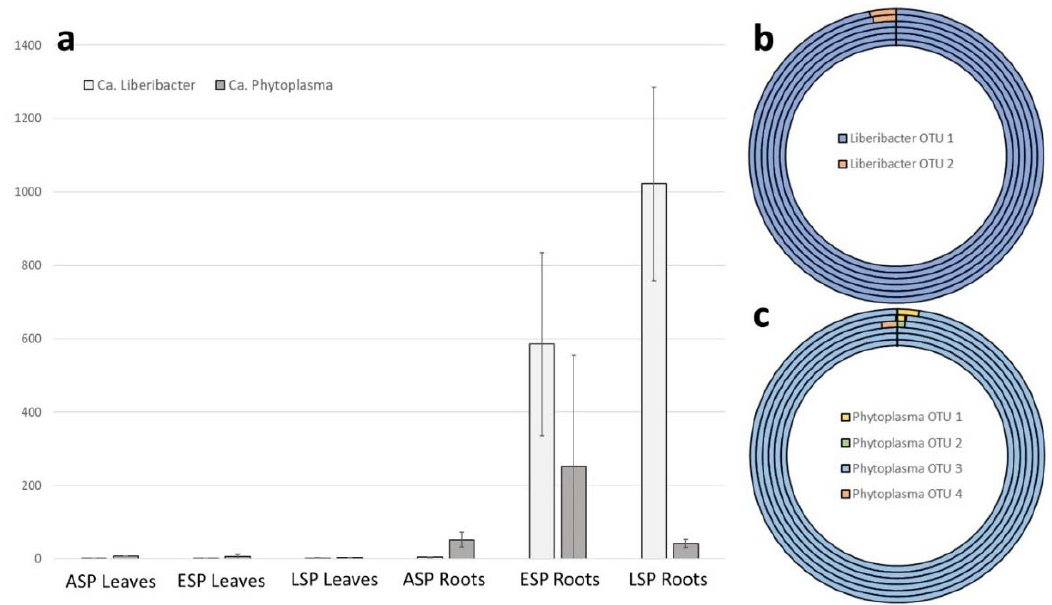
Figure 4. Graphs reporting the presence and abundance of pathogenic agents “ Ca . Phytoplasma” and “ Ca . Liberibacter” in the analyzed material according to metagenomic analyses: ( a ) Bar graph showing the average absolute abundance (number of OTUs) for each category of sample, with error bars indicating standard deviation among samples of the same category. Light grey bars indicate “ Ca . Liberibacter” while dark grey bars indicate “ Ca . Phytoplasma”; ( b ) circular graph indicating the relative abundance of different OTUs associated to “ Ca . Liberibacter” in the different samples. Each circular bar represents a different category of sample as follow, from innermost circle to outermost: ASP leaf, ESP leaf, LSP leaf, ASP root, ESP root, LSP root; ( c ) circular graph indicating the relative abundance of different OTUs associated to “ Ca . Phytoplasma” in the different samples. Each circular bar represents a different category of sample as follow, from innermost circle to outermost: ASP leaf, ESP leaf, LSP leaf, ASP root, ESP root, LSP root.